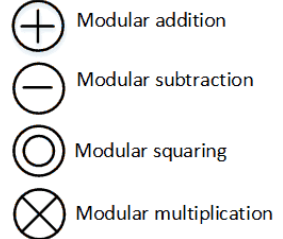
Figure 4. Legend for Figures